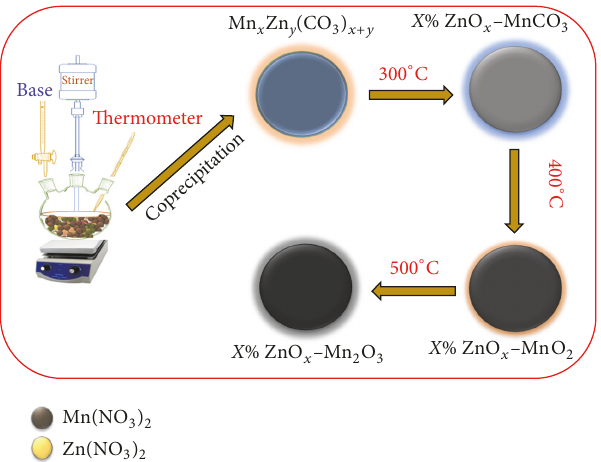
Scheme 1: Graphical illustration of the synthesis of the 𝑋 % ZnO –MnCO 3 oxide and other products x